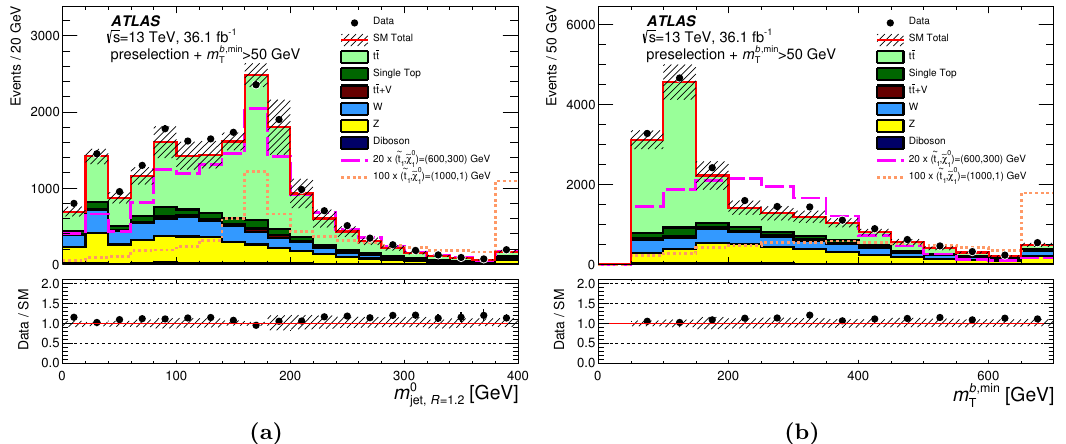
Figure 2. Distributions of the discriminating variables (a) m 0 and (b) m b; min after the jet ;R =1 : 2 T common preselection and an additional m b; min > 50 GeV requirement. The stacked histograms T show the SM prediction before being normalized using scale factors derived from the simultaneous (cid:12)t (detailed in section 7) to all dominant backgrounds. The \Data/SM" plots show the ratio of data events to the total SM prediction. The hatched uncertainty band around the SM prediction and in the ratio plots illustrates the combination of statistical and detector-related systematic uncertainties. The rightmost bin includes over(cid:13)ow